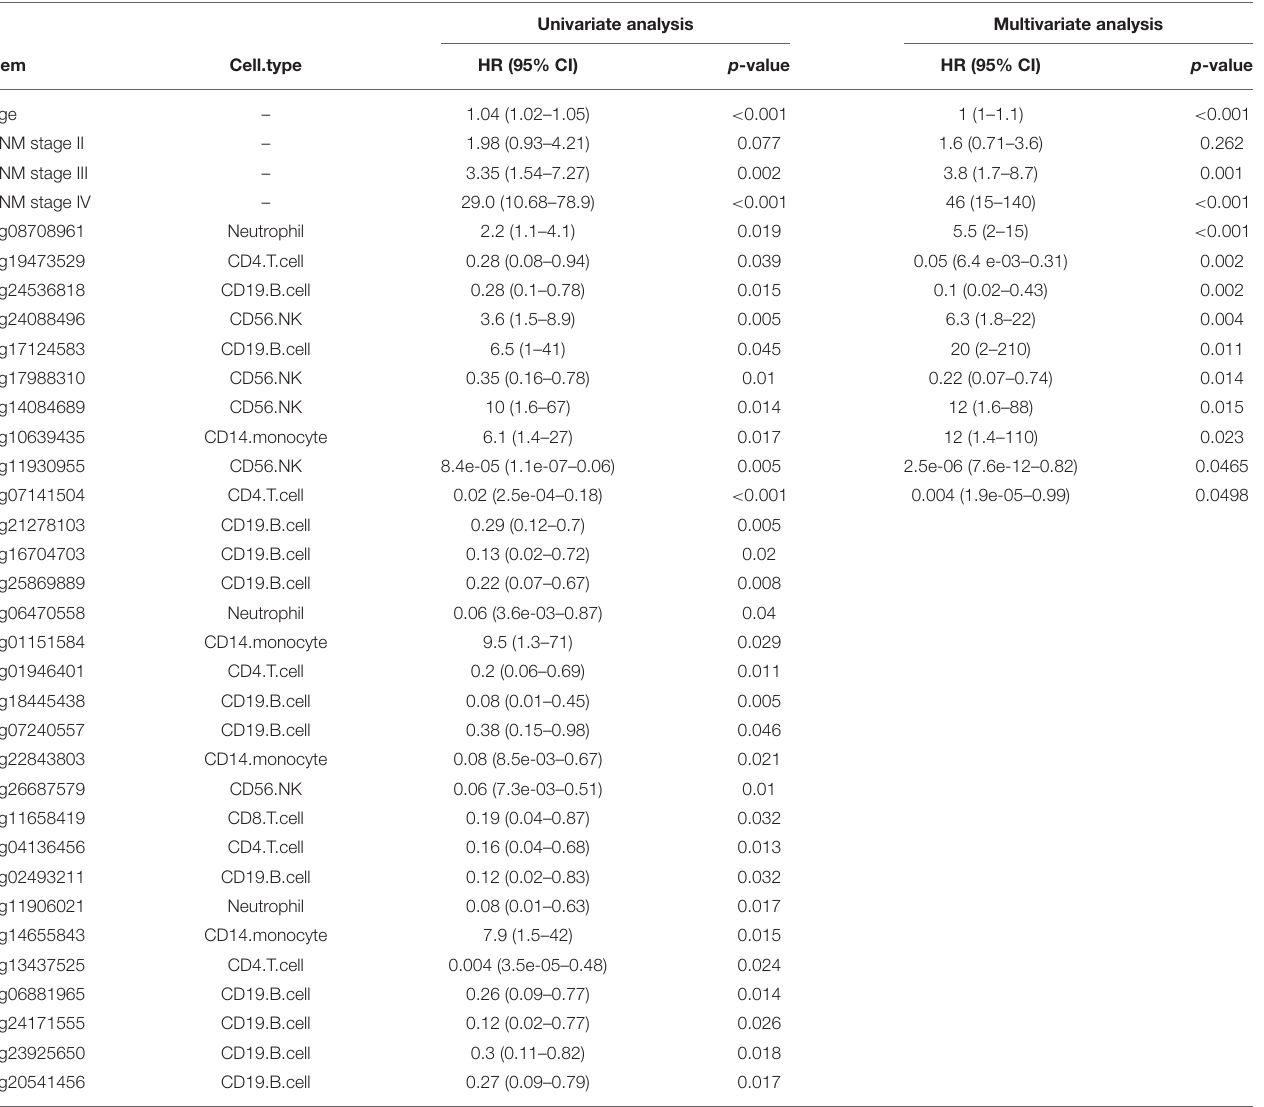
TABLE 1 | Statistical summary of the IC-SHMSs with prognostic value. Univariate analysis Multivariate